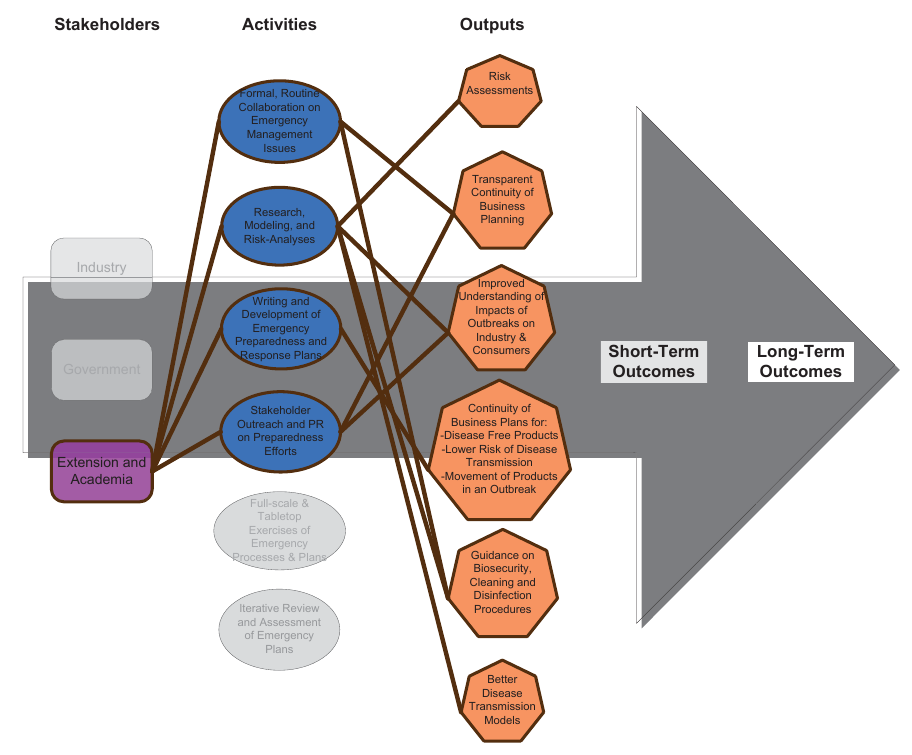
Figure 3. Extension and academia’s lead responsibilities in continuity of